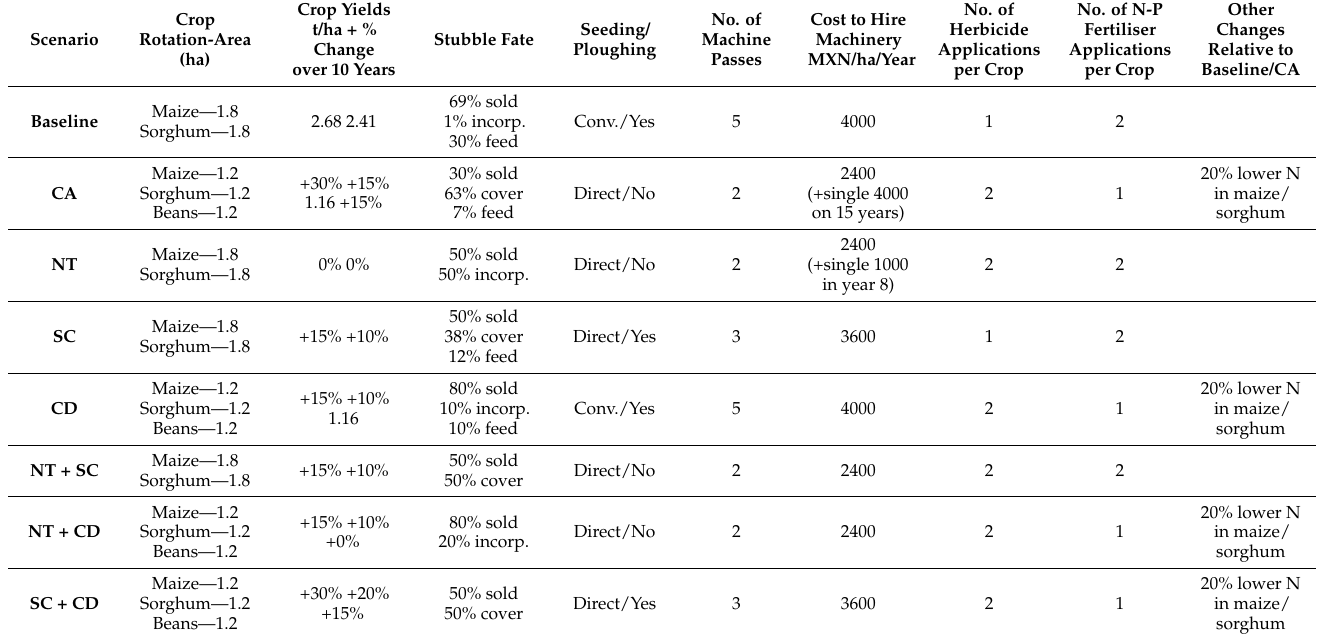
Table 1. Key model parameters used in the whole-farm simulation for the representative farm (T6) in southern Guanajuato and changes in modelling parameters between the baseline and nine innovation scenarios with various combinations of conservation agriculture (CA), no-tillage (NT), soil cover (SC), crop diversification (CD), new hybrid maize variety (NewVar) and new legume crop (NewLeg) concerning crop rotation, percent incremental yield change over the 10 years, stubble fate (sold or retained, incorporated, ground cover, or livestock feed), seeding (conventional or direct), number of machine passes and machine hire cost, number of herbicide and N-P fertiliser applications, and other changes relative to baseline or CA (for CA+